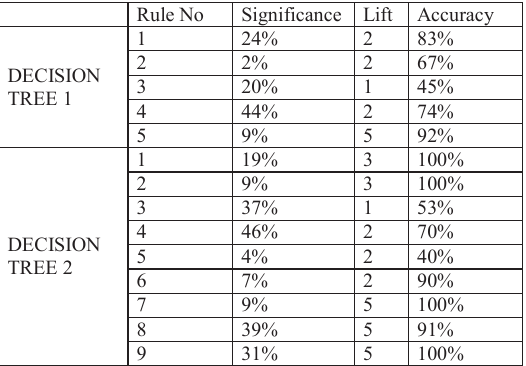
Table 9. Extracted rule evaluation from Stage